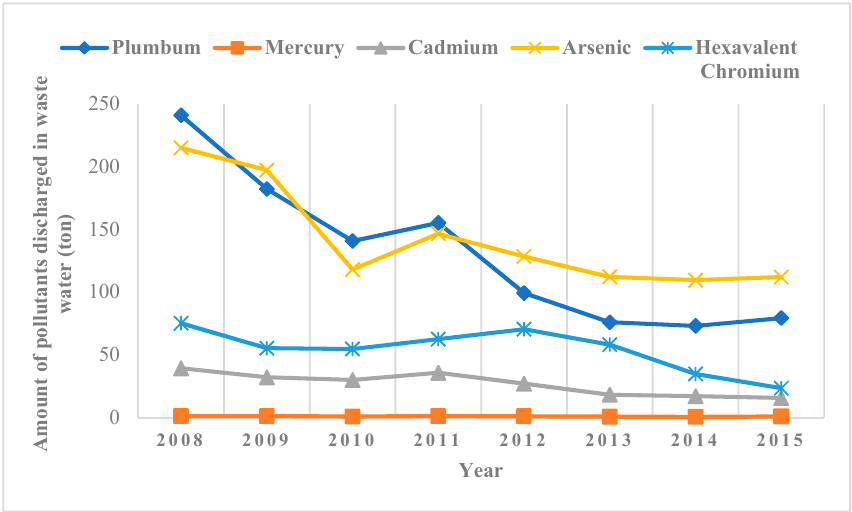
Figure 1. Trends of five heavy metal pollutants emissions in China.